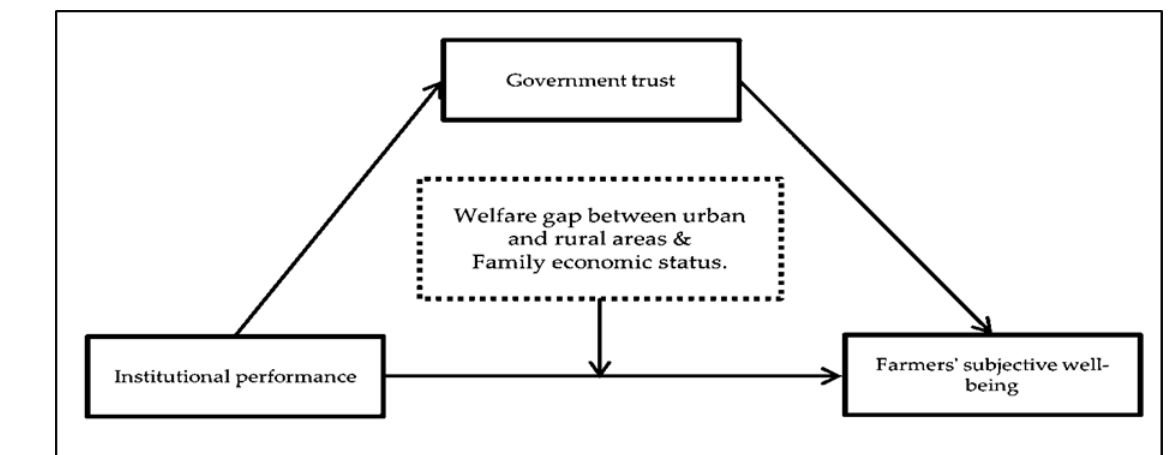
Figure 1. Proposed framework for the study.